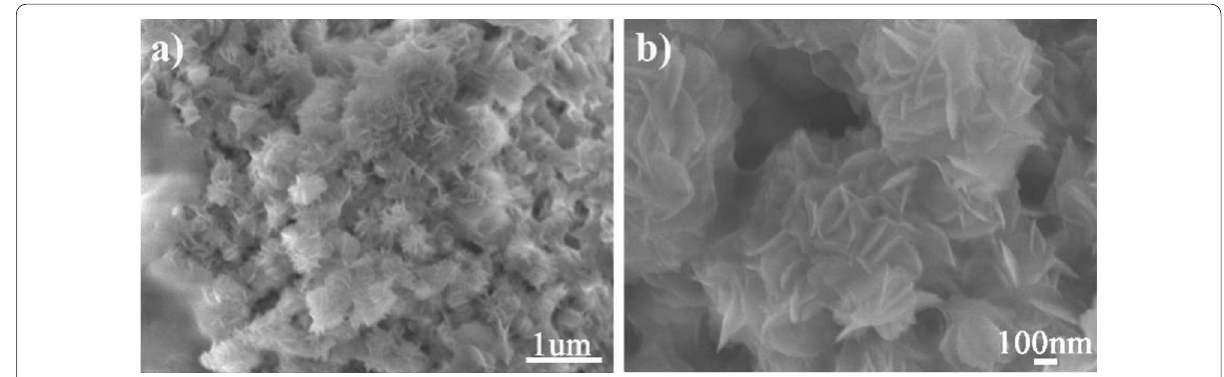
Fig. 1 SEM images of CdW 12